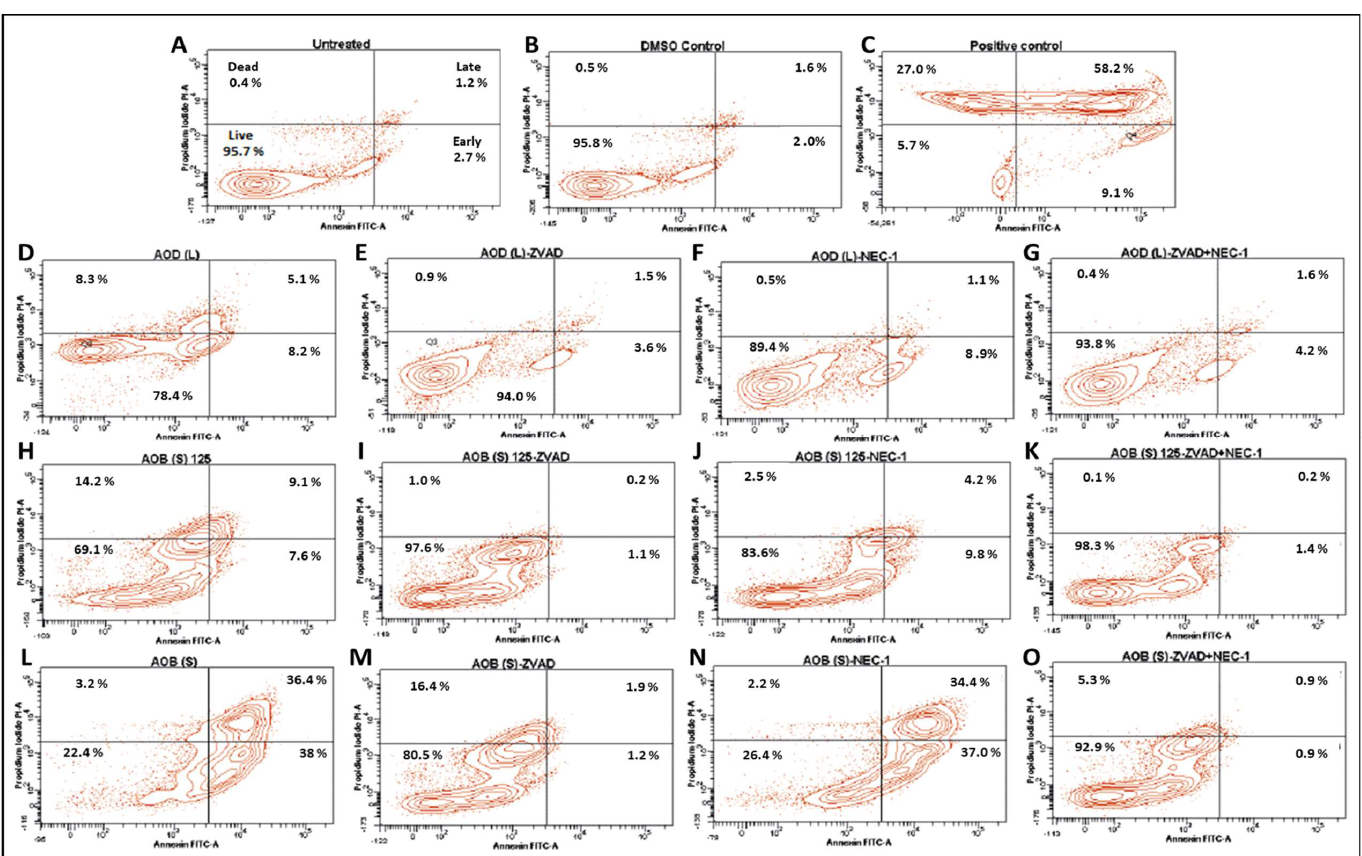
Figure 7. Annexin V-FITC/propidium iodide (PI) analysis of HeLa cells treated with 250 µg/mL of the A. orientalis dichloromethane leaf (AOD (L)) fraction or 125 and 250 µg/mL n-butanol stem (AOB (S)) fraction for 24 h. Samples: ( A ) Untreated; ( B ) DMSO control; ( C ) Positive control-treated; ( D ) 250 µg/mL AOD (L)-treated; ( E ) 250 µg/mL AOD (L)-treated cells pretreated with ZVAD, or ( F ) NEC-1, or ( G ) both; ( H ) 125 µg/mL AOB (S)-treated; ( I ) 125 µg/mL AOB (S)-treated cells pretreated with ZVAD, or ( J ) NEC-1, or ( K ) both; ( L ) 250 µg/mL AOB (S)-treated; ( M ) 250 µg/mL AOB (S)-treated cells pretreated with ZVAD, or ( N ) NEC-1, or ( O ) both. ZVAD = Z-VAD-FMK; NEC-1, Necrostatin 1. The DMSO Control sample contains the same amount of DMSO as in the 250 µg/mL sample of the treatment.